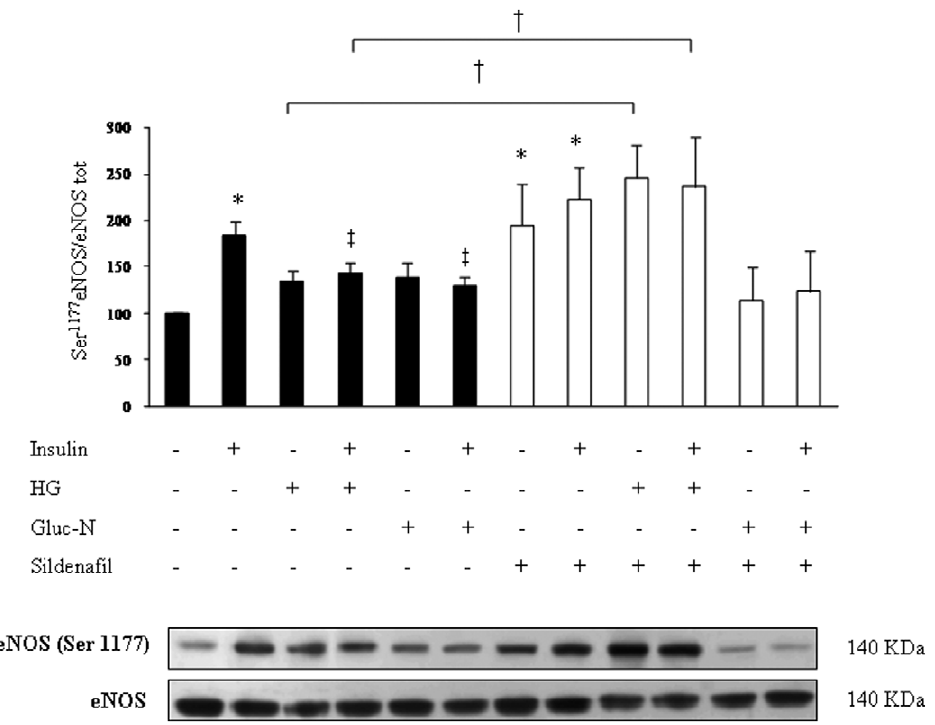
Figure 3. eNOS Ser 1177 phosphorylation after sildenafil treatment. Sildenafil chronic treatment (1 m M/72 h) enhances eNOS phosphorylation in basal condition and after HG treatment, but not significantly after Gluc-N treatment. Full bars represent conditions without sildenafil, dashed bars represent sildenafil treatment. Ctrl was expressed as 100%. Means 6 S.E. (n=5). * p , 0.05 vs Ctrl, { p , 0.05 vs insulin; { p , 0.05 vs HG; {{ p , 0.05 vs HG + insulin.